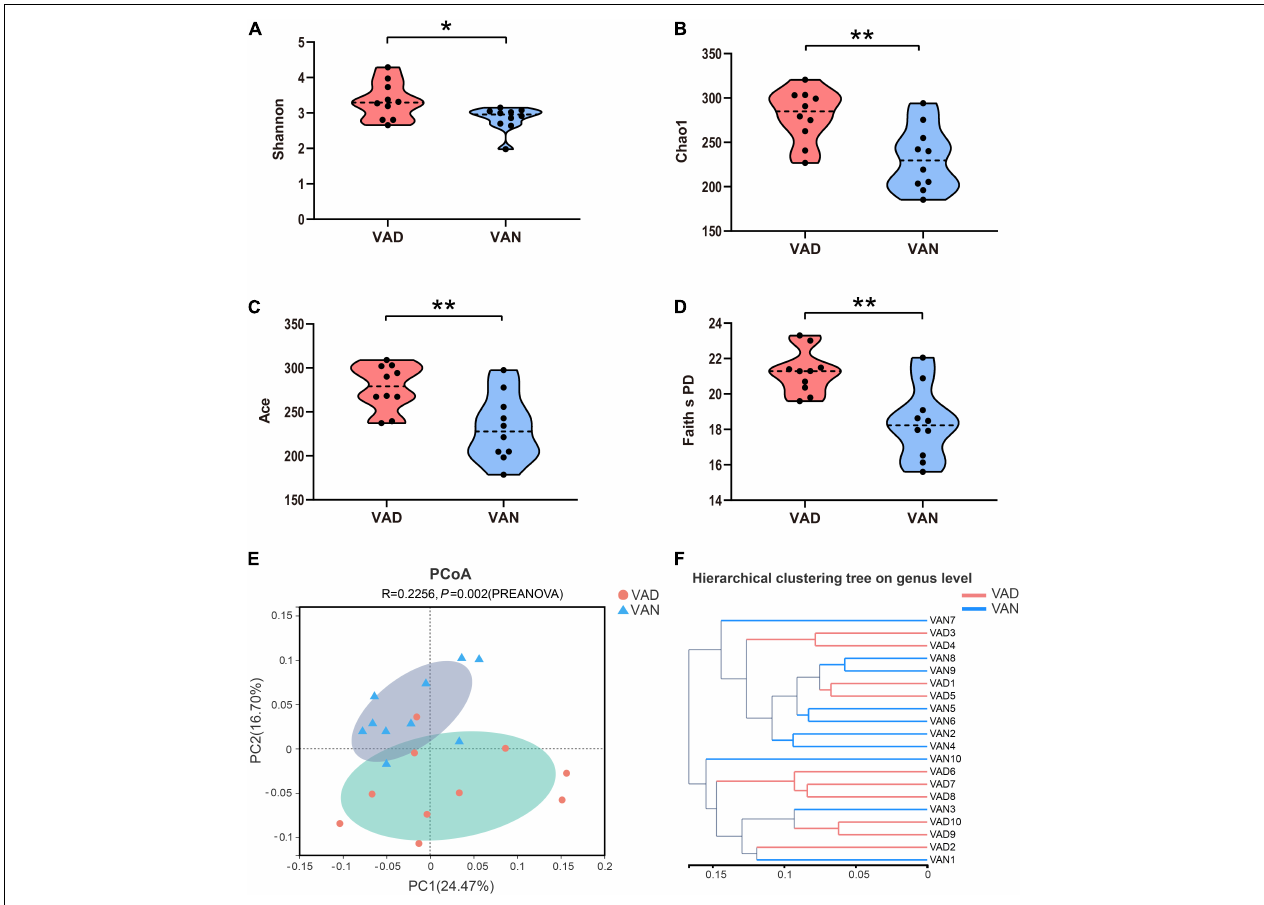
FIGURE 6 | Alpha- and Beta-diversity indices of the fecal microbiota of the APP/PS1 transgenic mice after consumption of the VAD- or VAN-diet for 45 weeks. (A) Shannon index. (B) Chao1 index. (C) Ace index. (D) Faith’s phylogenetic diversity index. (E) Principal coordinates analysis (PCoA) plot based on the unweighted UniFrac distance. A red dot denotes samples from the VAD group, a cyan triangle denotes samples from the VAN group. (F) Hierarchical clustering of the individual samples based on the unweighted UniFrac distance. VAD, vitamin A deficiency diet; VAN, vitamin A normal diet. n = 10 per group. ∗ P < 0.05 and ∗∗ P < 0.01.